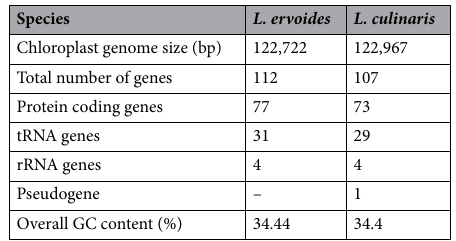
Table 1. Comparison of L. ervoides cp genome and L. culinaris cp genome deposited to the GenBank features.